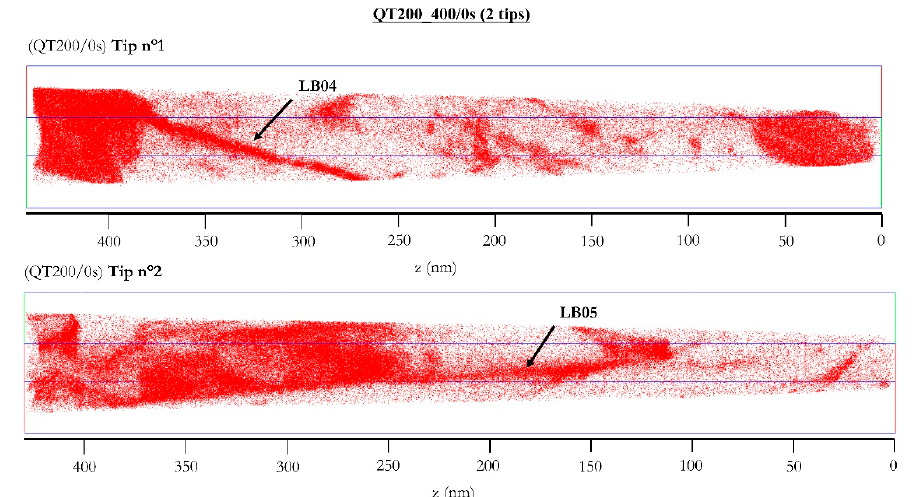
Figure 19. Carbon distribution maps in martensite showing two carbon segregations on lath boundaries in tip n ◦ 1 and tip n ◦ 2 (LB04 and LB05) (QT200 PT / t = 400 ◦ C / 0 s).